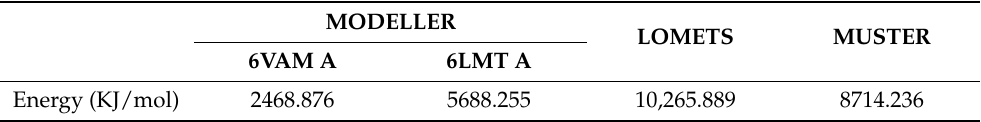
Table 3. Energy minimisation values through SPDBV.